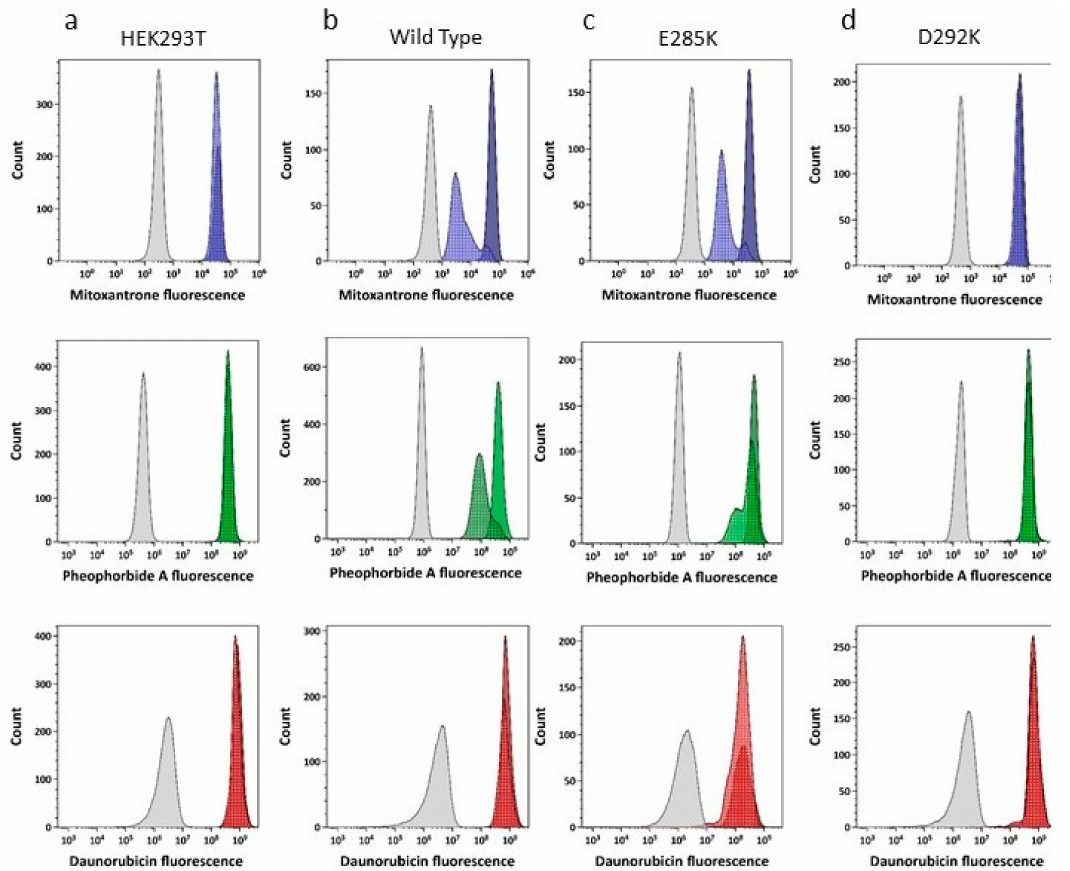
Figure 4. Altered drug transport function in ABCG2 NBD interface mutants. Single channel histogram plots to quantify mitoxantrone (top row), pheophorbide A (middle panels) and daunorubicin (lower panels) fluorescence in HEK293T cells ( a ), cells expressing wild type ABCG2 ( b ), and two NBD interface mutants (E285K, ( c ) and D292K, ( d )). Grey histograms represent autofluorescence of cells. The dotted blue, green and red histograms depict equilibrium level of substrate accumulation (mitoxantrone, pheophorbide-a and daunorubicin respectively). The e ff ects of inclusion of Ko143, a specific ABCG2 inhibitor, are shown in the solid colour